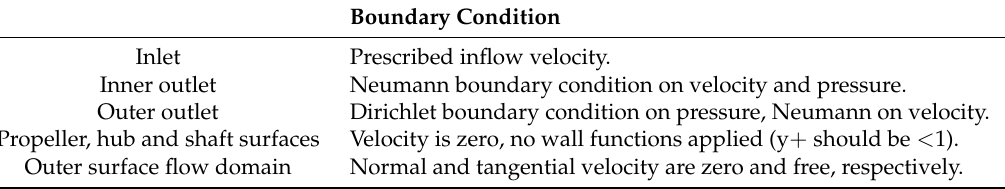
Figure 1. Domain and grid for Reynolds-averaged-Navier–Stokes computations. Table 5. Boundary conditions for Reynolds-averaged-Navier–Stokes calculations.